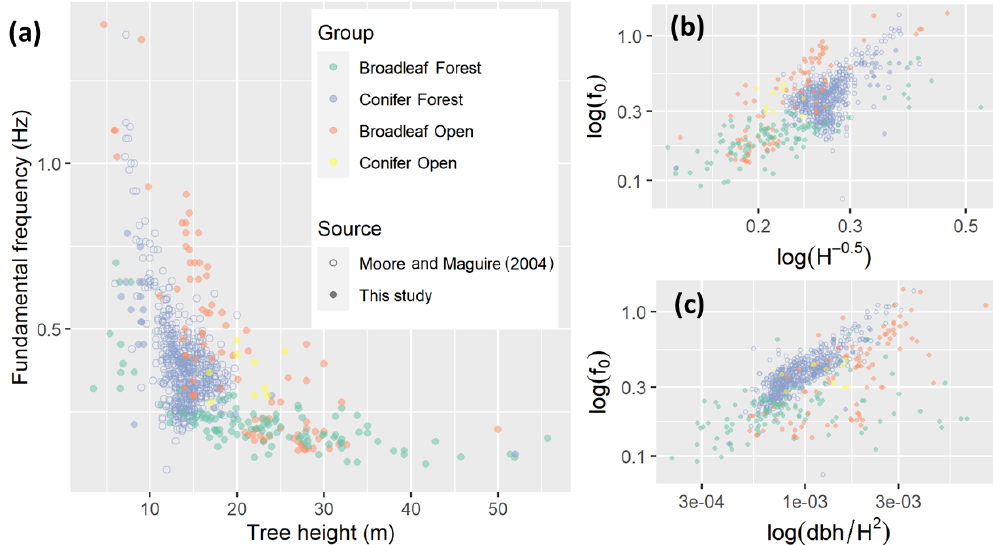
Figure 2. (a) Fundamental frequency against tree height on a linear scale. Small panels on log–log scales show fundamental frequency against (b) the simple pendulum model and (c) the cantilever beam model.